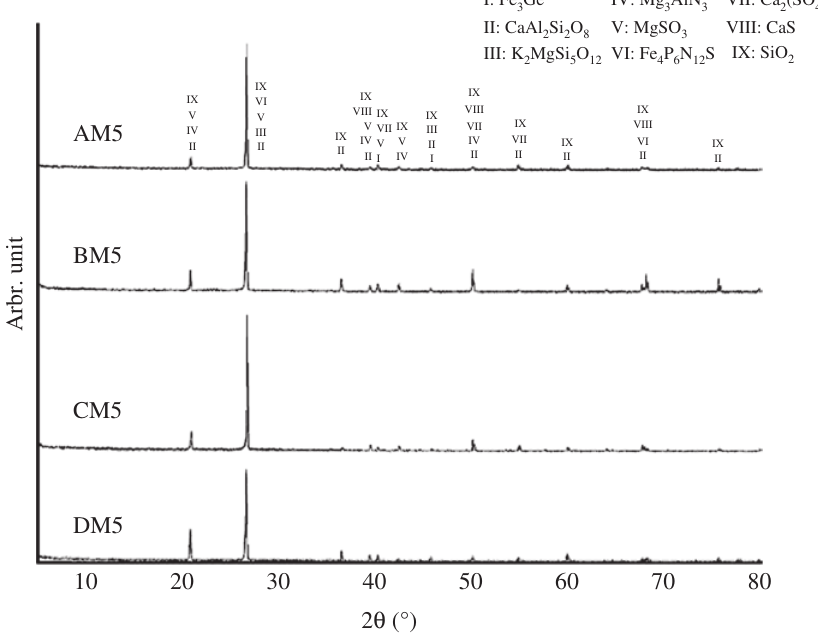
Figure 11: XRD patterns of AAFA geopolymer (alkaline solution/binder ratio of 0.5) with the various curing temperatures at the age 28